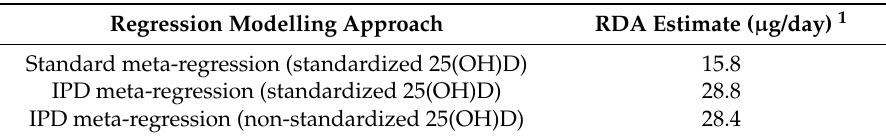
Table 3. The RDA estimates for vitamin D as derived using different regression modelling